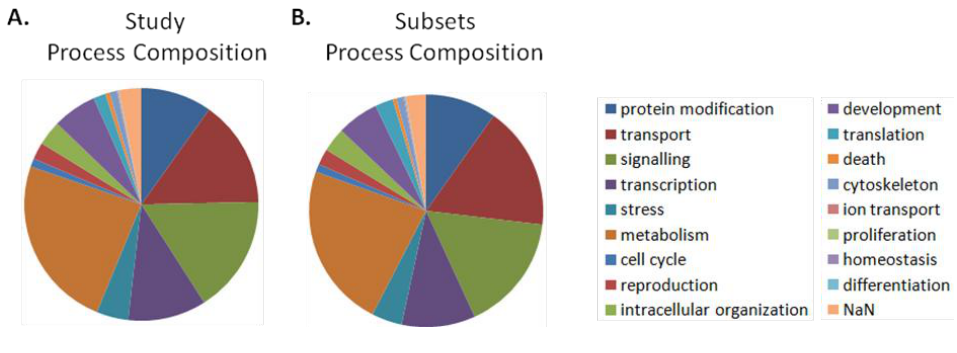
Figure 11. Distribution of cellular processes among networks and sub-networks investigated in this study. ( a ) ―Study‖ Process Composition ( b ) ―Subsets‖ Process Composition. ( a ) The Generic Slim database of gene-process associations was accessed from Gene Ontology and each network was annotated according to the most commonly occurring process term among genes within the network. ( b ) For all 497 networks found to be differentially activated in this study, the networks were re-annotated according to the most commonly occurring term among the significant sub-set (as the analysis of differential activity involves identification of a significant subset of genes within each network).